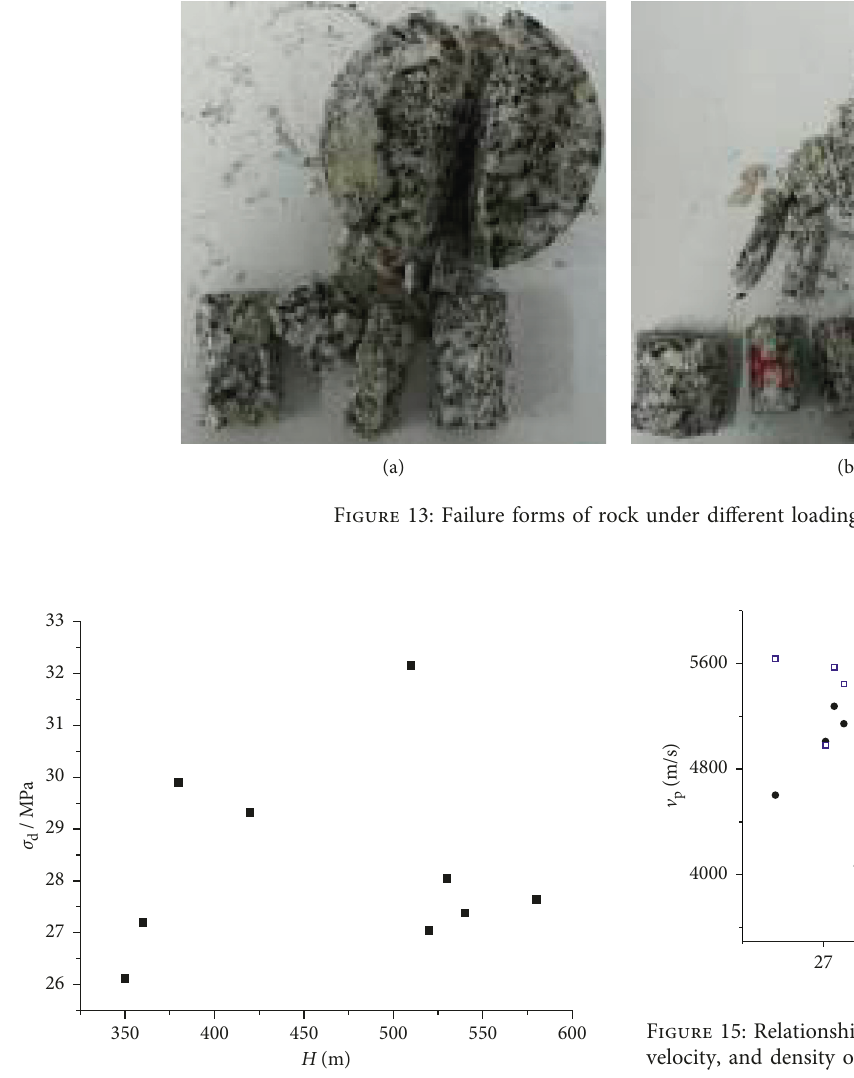
Figure 14: Relationship between dynamic tension strength and different depth.